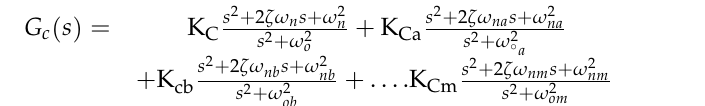
Figure 13. The voltage control response for the DC link.